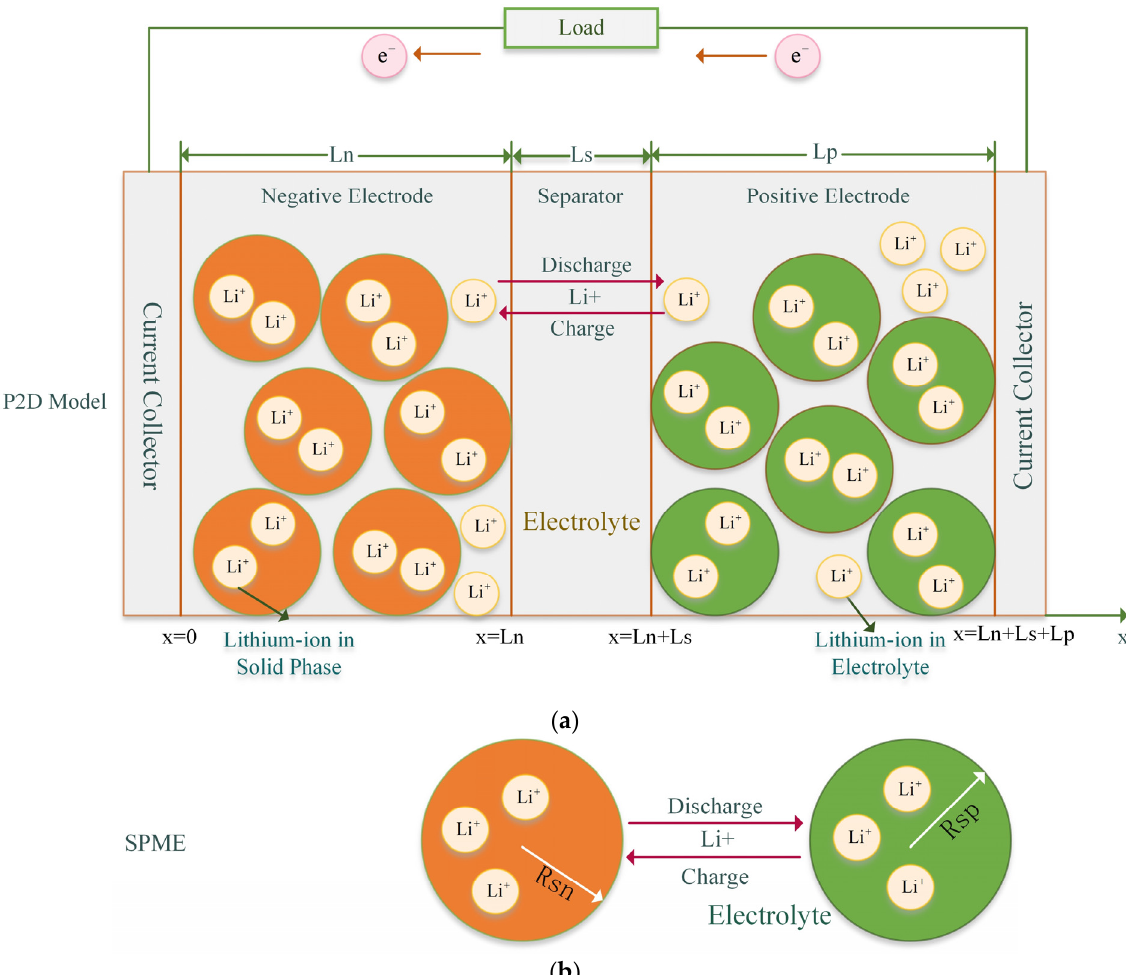
Figure 1. Schematics of ( a ) the P2D model and ( b ) the SPME.